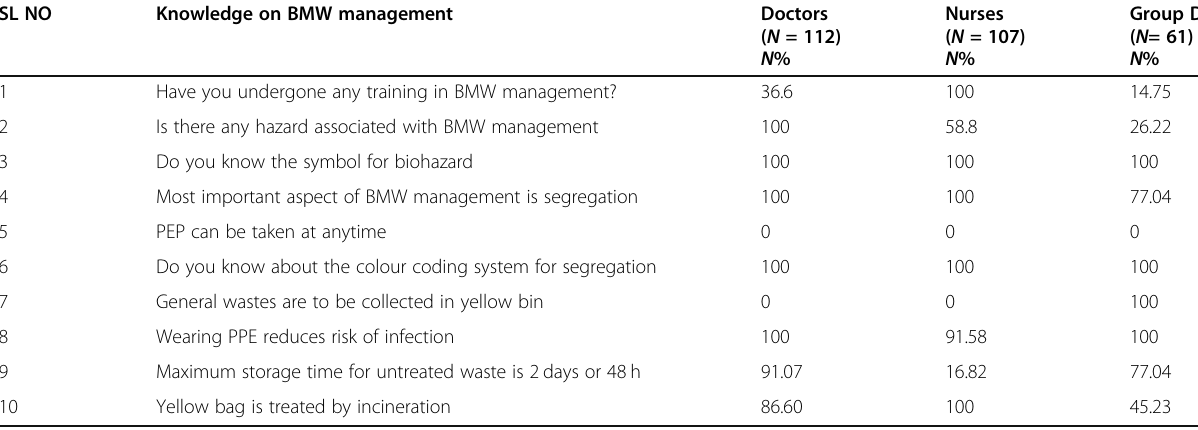
Table 1 Knowledge of health care workers on BMW management SL NO Knowledge on BMW